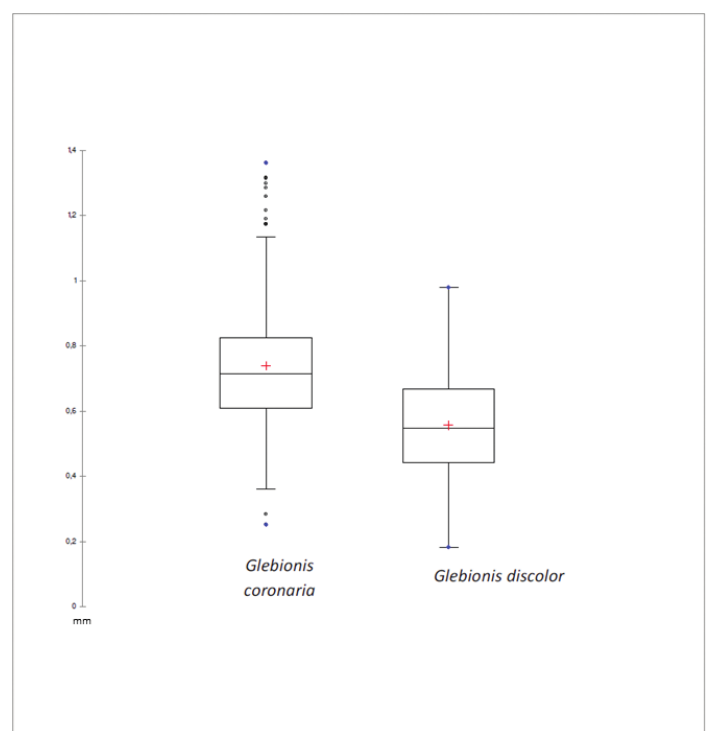
Figure 4. Statistical analysis by box plot of cypselas wing width of Glebionis coronaria and G. discolor